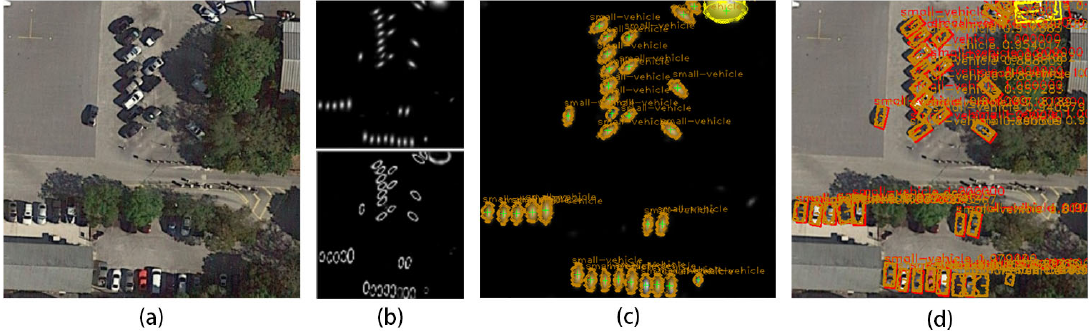
Figure 2. Overall pipeline: ( a ) input; ( b ) Center Field (top) and Edge Field (bottom); ( c ) post-processing by ellipse region fitting (ERF); and ( d ) the detection